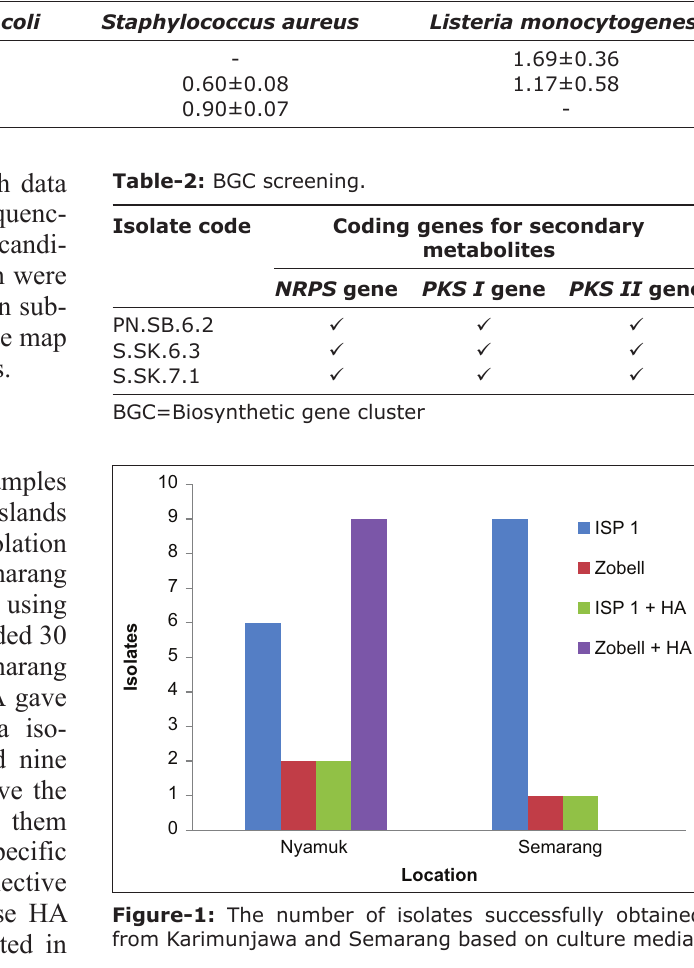
Table-1: Antibacterial activity screening of Karimunjawa and Semarang isolates. Isolate code